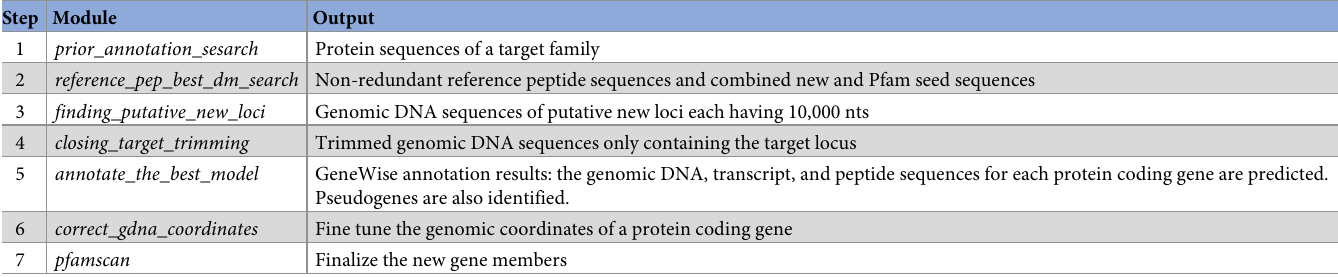
Table 1. Annotation modules and outputs of